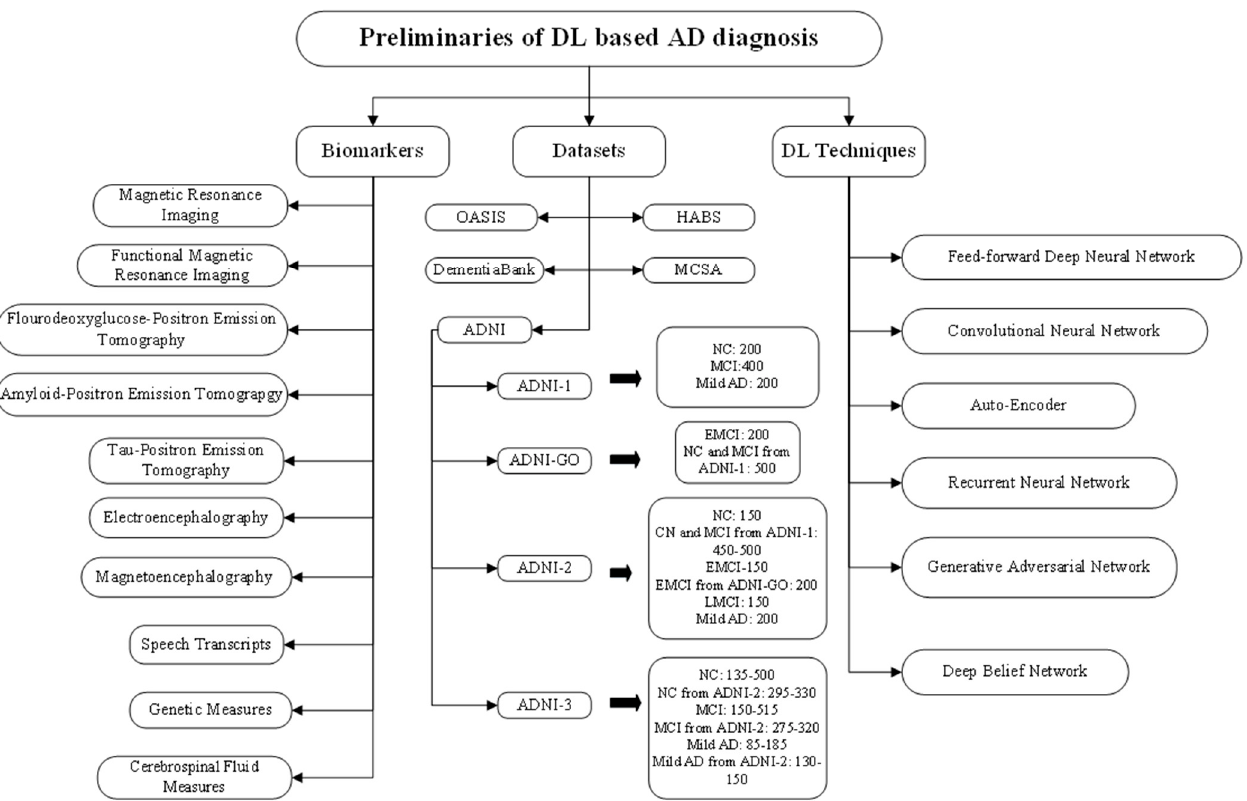
Figure 1. Presents the preliminaries required for DL-based diagnosis of AD. These preliminaries include biomarkers of AD, AD datasets and DL